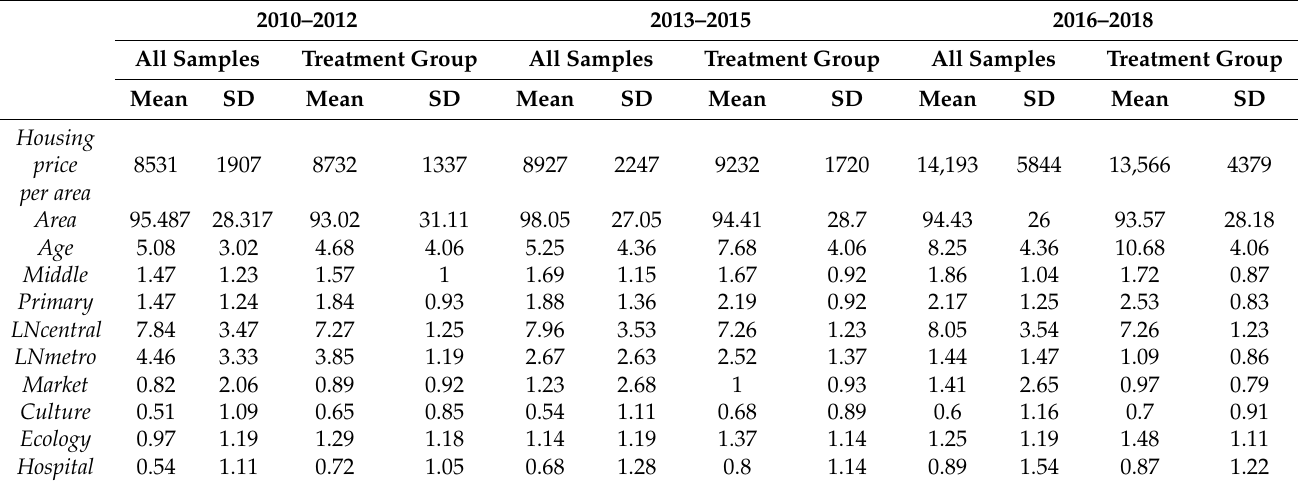
Table 3. Descriptive statistics of the